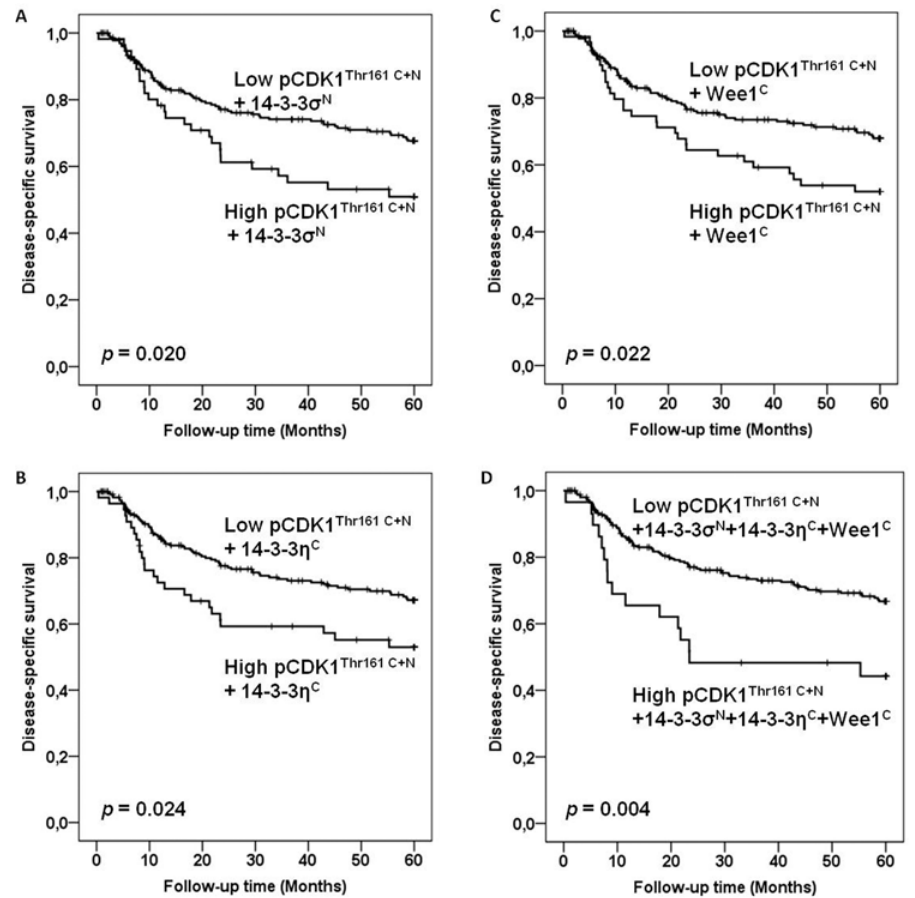
Fig 3. Survival curves using the Kaplan-Meier method (288 VSCC without pre-surgery treatment cases). The Kaplan-Meier curves of disease-specific survival in relation to combinations of (A) (pCDK1 Thr161 C+N + 14-3-3 σ N ), (B) (pCDK1 Thr161 C+N + 14-3-3 η C ), (C) (pCDK1 Thr161 C+N + Wee1 C ) and (D) (pCDK1 Thr161 C +N + 14-3-3 σ N + 14-3-3 η C + Wee1 C ). The p -values differ slightly from those in Table 2 due to the use of the log-rank test as opposed to the Cox-regression